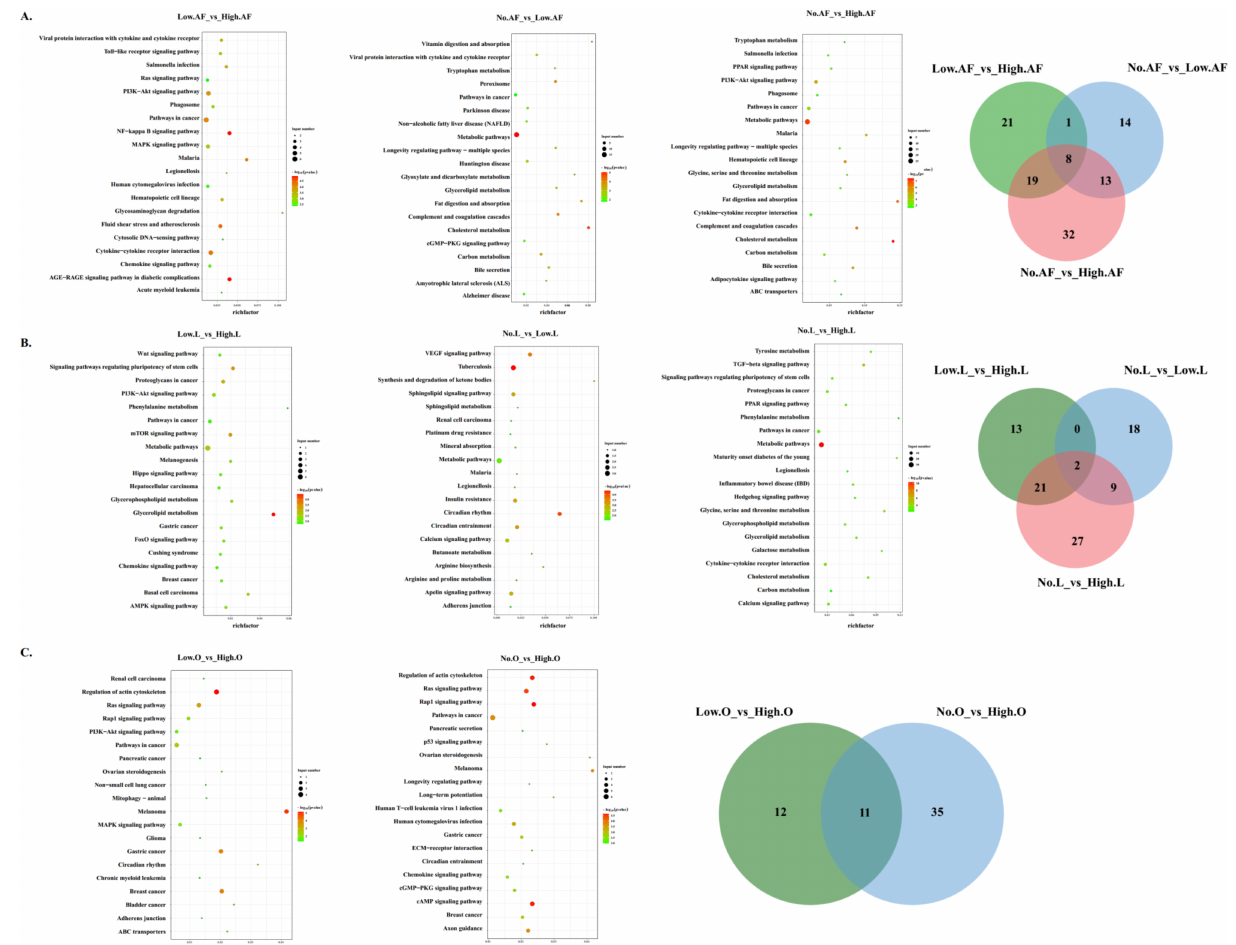
Figure 3. Functional annotation of the DEGs between different performances of geese in abdominal fat ( A ), liver ( B ), and ovarian stroma ( C ). “AF” means abdominal fat, “L” means liver, “O” means ovarian